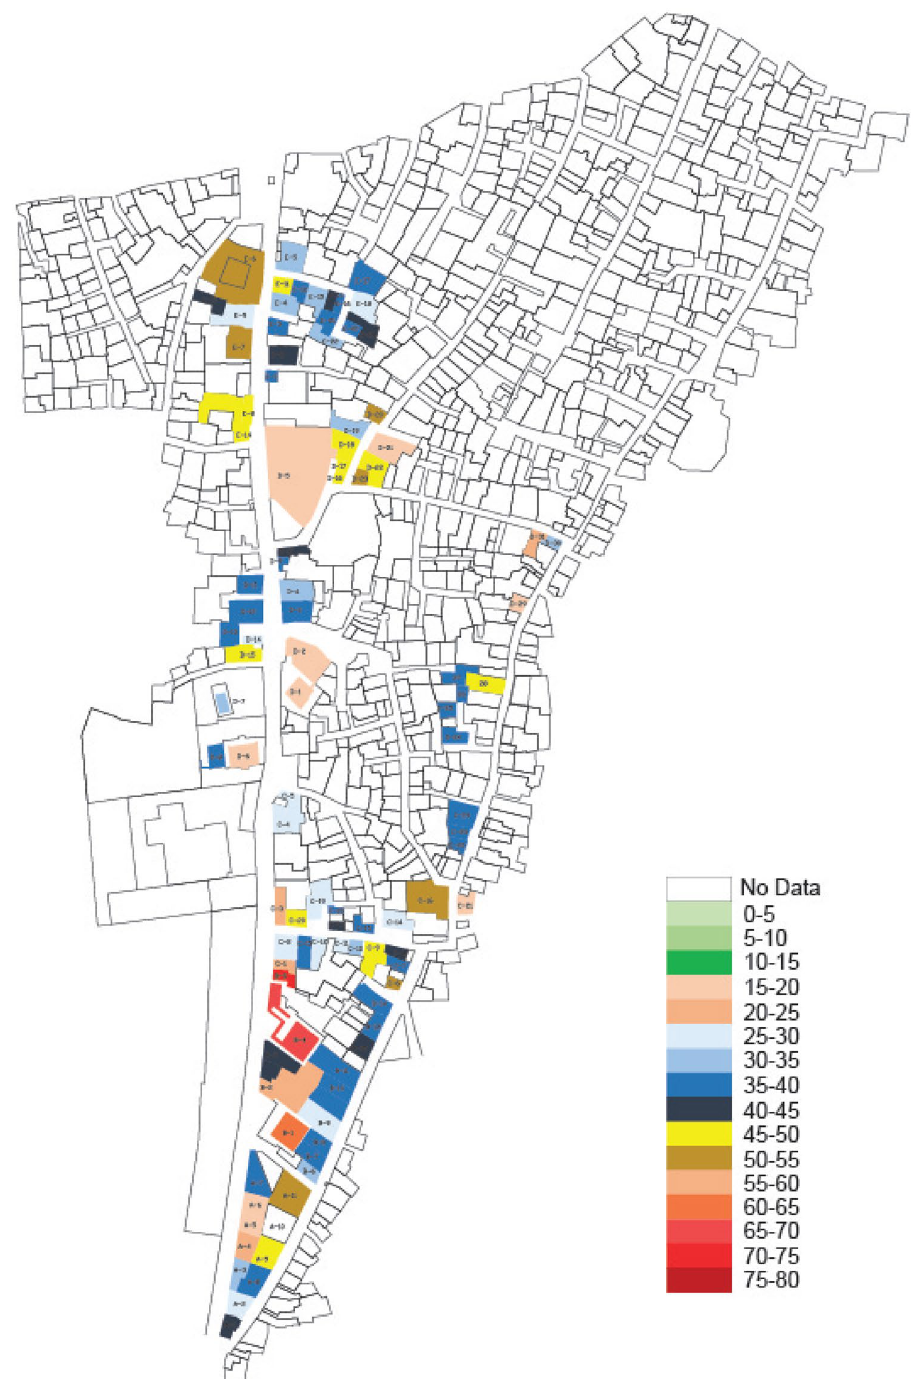
Fig. 7 Vulnerability index map